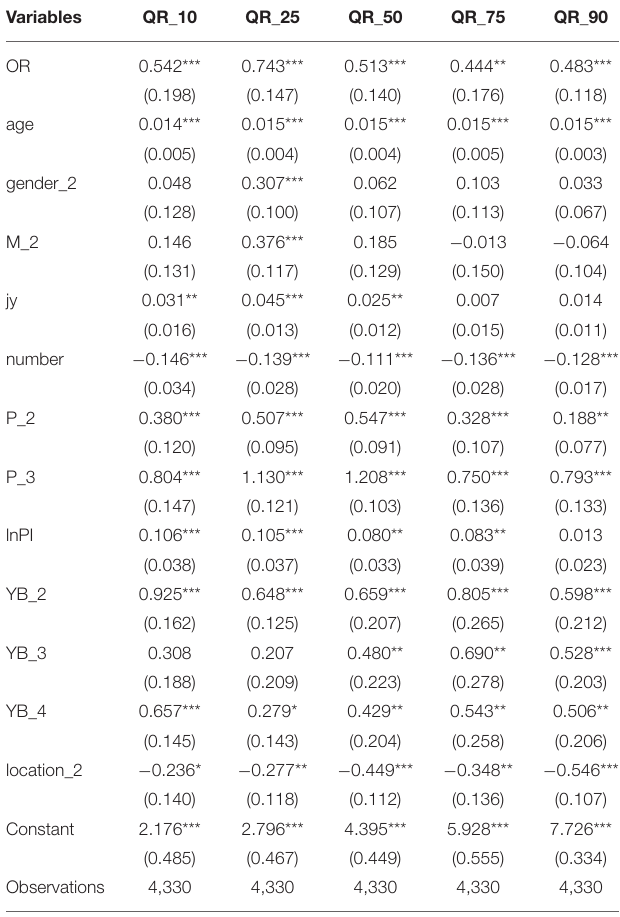
TABLE 6 | Regression results of household health expenditure in western China.